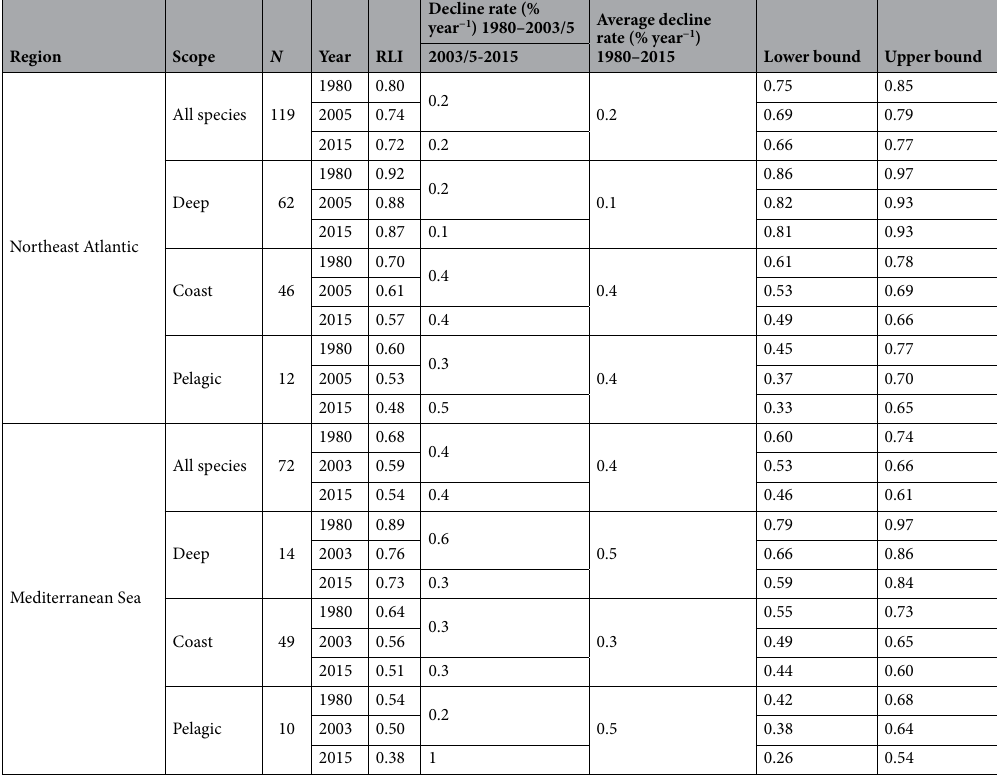
Table 1. Red List Index values for Northeast Atlantic and Mediterranean Sea sharks and rays between 1980 and 2015. Decline rates are calculated as the annual average between each assessment period, then the overall average taken from both